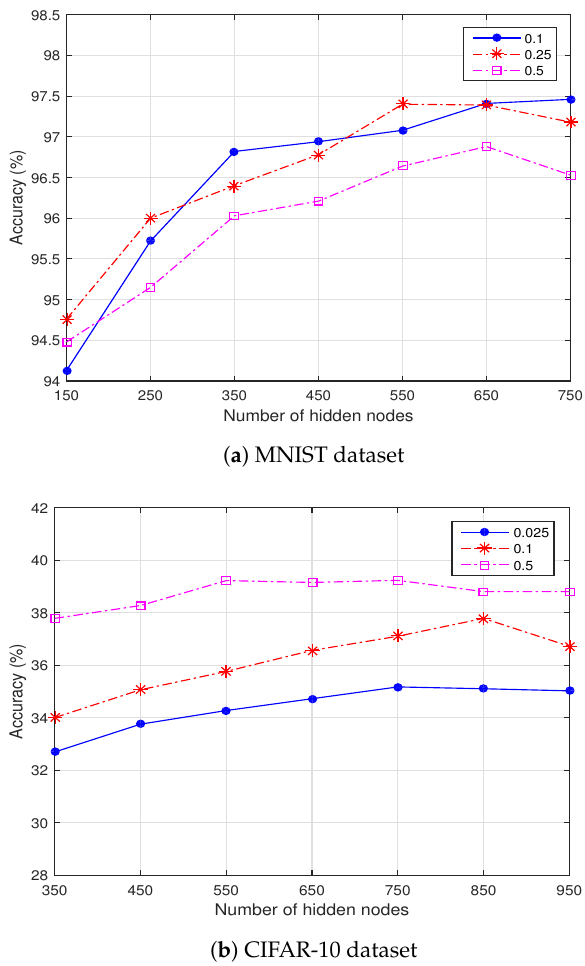
Figure 3. The relationship between the number of hidden nodes and classification performance in the REAN autoencoder